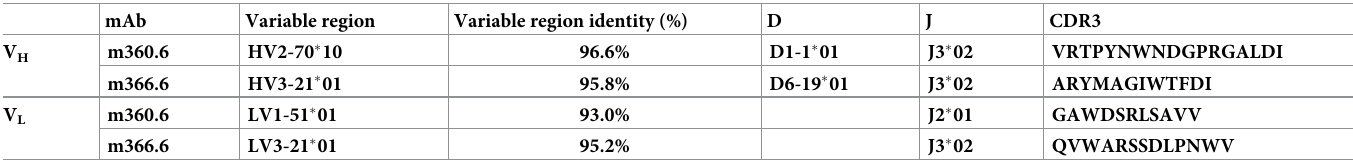
Table 3. Genetic analysis of the heavy and light chain variable regions of DENV DIII-specific antibodies. mAb Variable